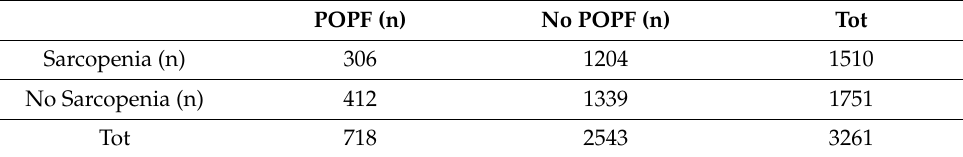
Table 5. Patients undergoing pancreatoduodenectomy.